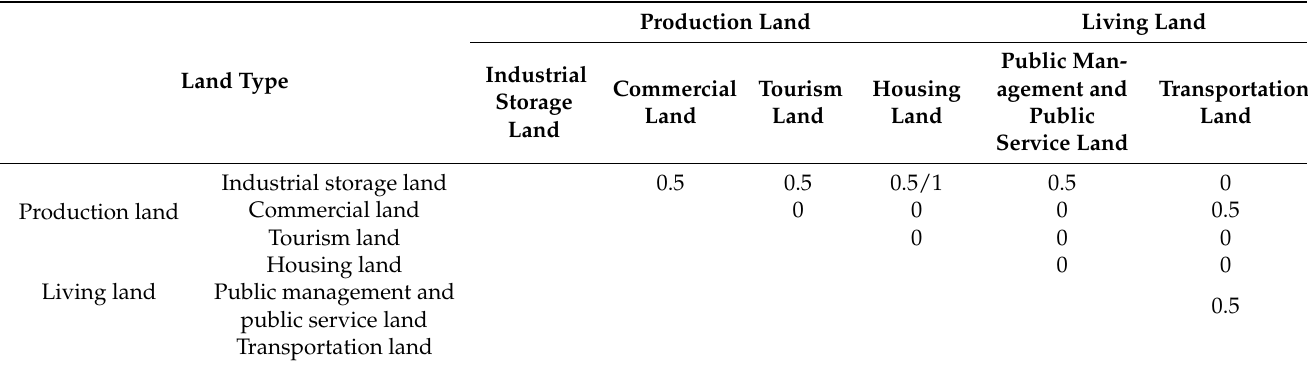
Table 3. Compatibility values between production land and living land in a rural settlement.